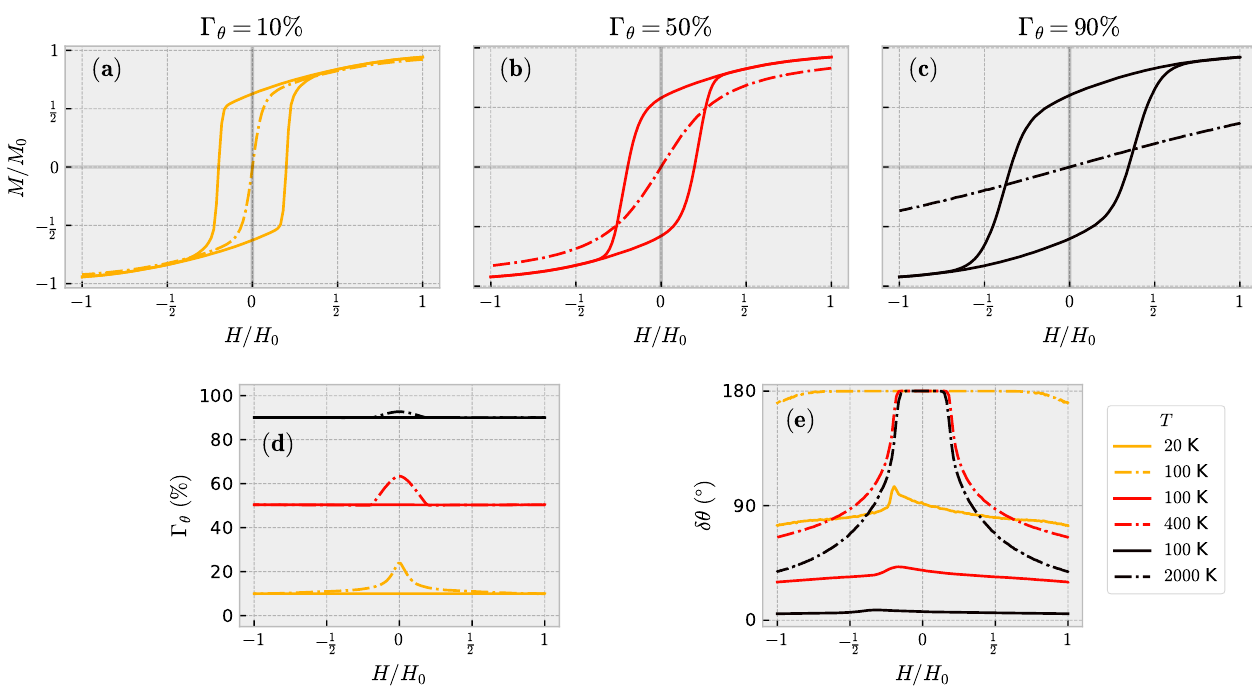
Figure 6. Reduced magnetization for percentages of acceptance of ( a ) 10%, ( b ) 50% and ( c ) 90%, ( d ) acceptance rate and ( e ) cone aperture depending on the external field for different temperature values. At low temperatures magnetic hysteresis (solid lines) is observed whereas for high enough temperatures a superparamagnetic behavior occurs (dashed